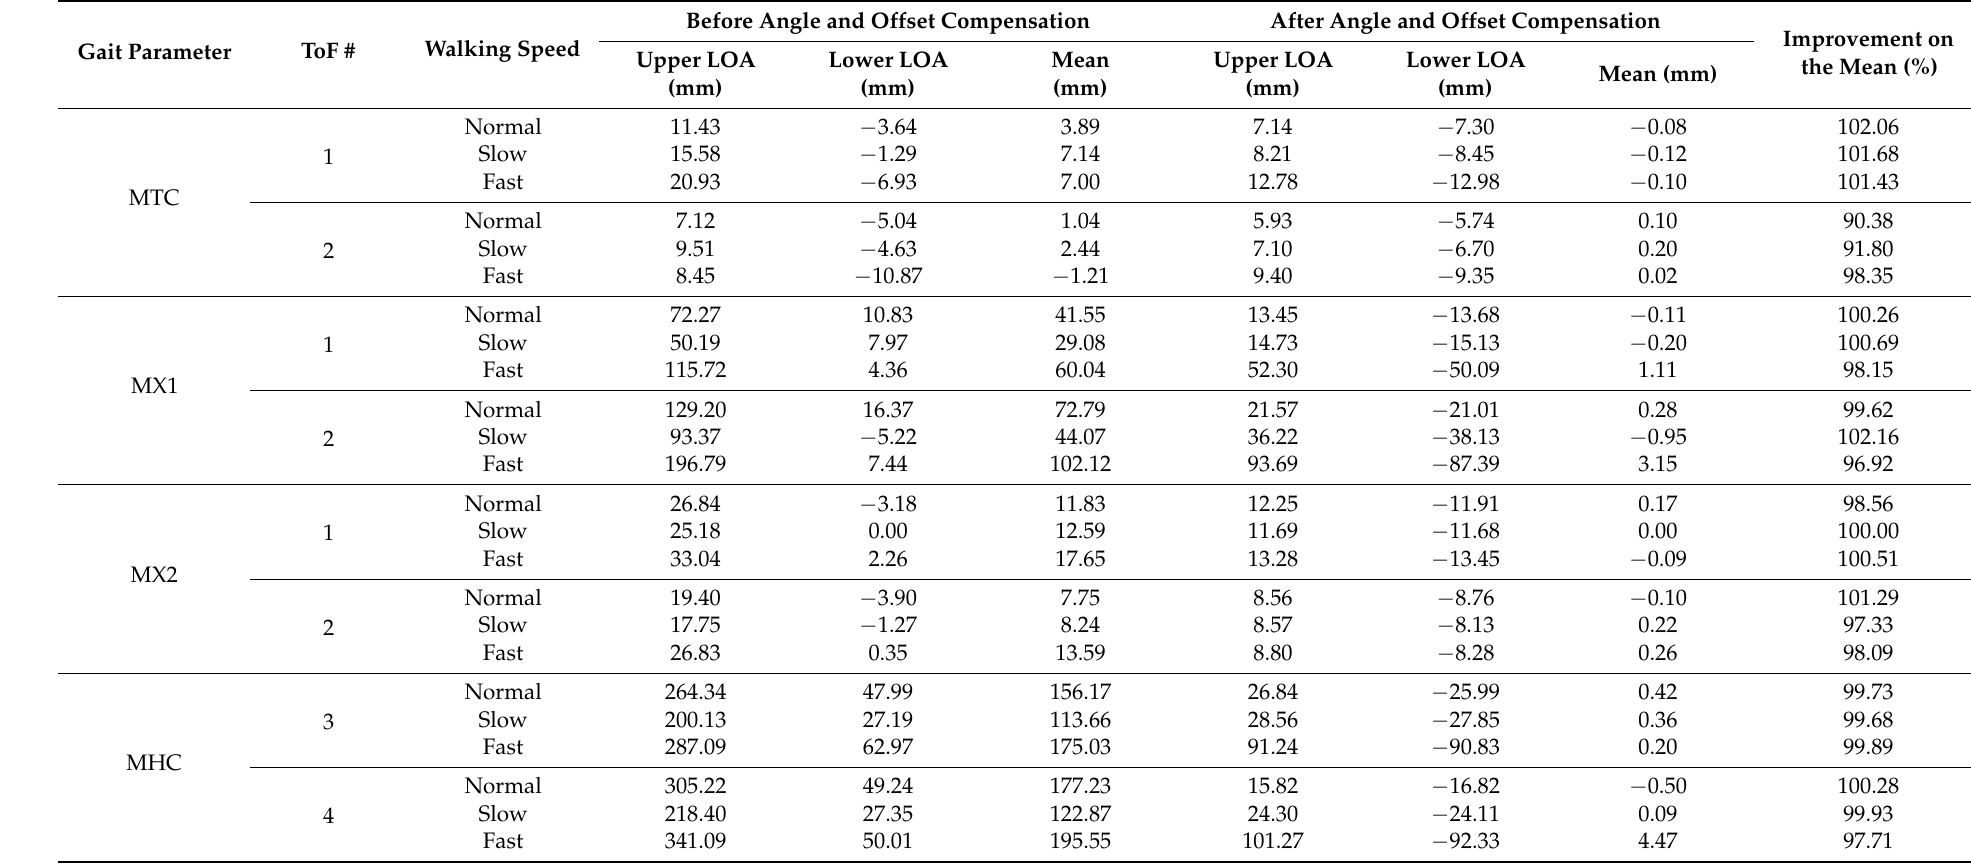
Table 4. The Bland-Altman limits of agreement (LOA) and mean before and after angle and offset compensation.